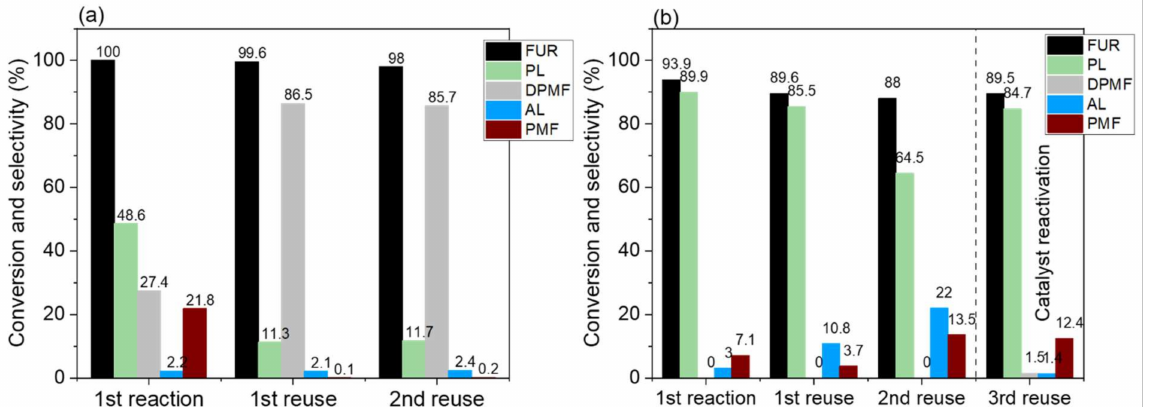
Figure 7. Reuse evaluation of the commercial ( a ) and alkaline-treated beta zeolite ( b ) in the domino reaction of furfural conversion. Reaction conditions: ( a ) 0.34 mmol of FUR, 50 mg of catalyst, 1500 µ L of isopropanol, 110 ◦ C, for 24 h.; ( b ) 0.34 mmol of FUR, 50 mg of catalyst, 750 µ L of isopropanol, 130 ◦ C, for 24 h. Reactivation conditions: calcination at 550 ◦ C for 5 h (10 ◦ C min − 1 ) in a static air